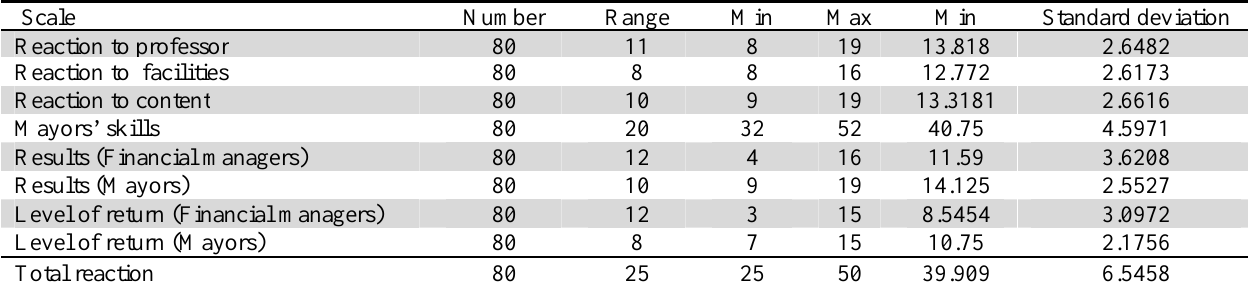
The results of some basic statistics Scale